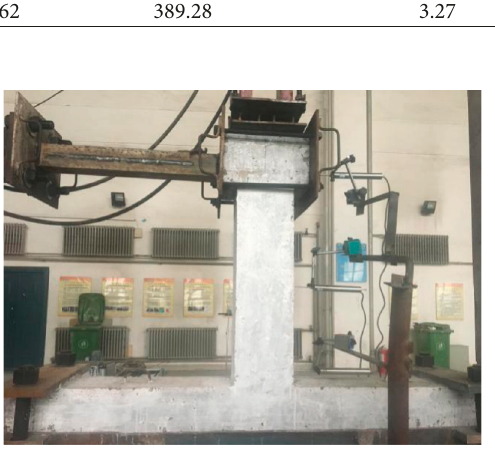
Figure 5: Test live